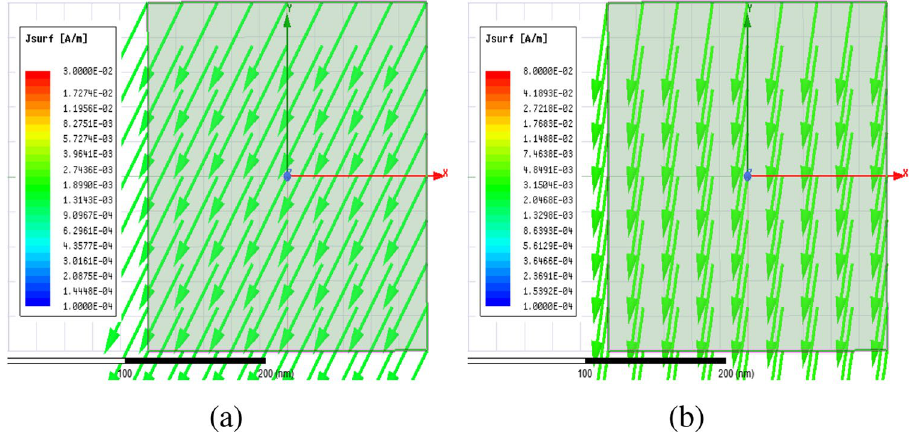
Figure 6. Surface current on the ground plane ( a ) at 34.12 THz and ( b ) at 35.44 THz.